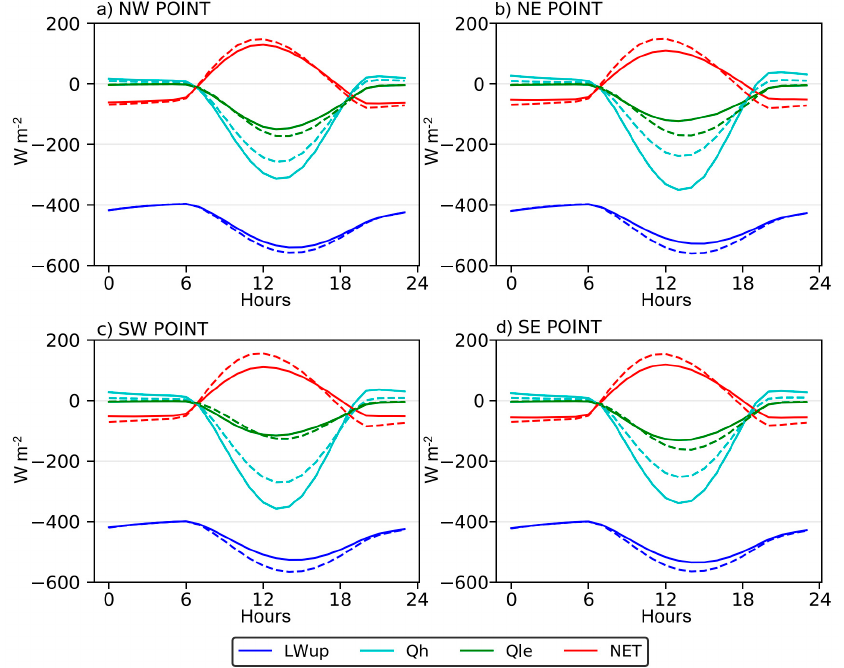
Figure 9. Components of the surface energy balance at the surface in the control (solid lines) and revised (dashed lines) simulations. Longwave upward radiation (LWup, blue), sensible heat flux (Qh, cyan), latent heat flux (Qle, green) and the surface net flux (NET = SWnet + LWnet + Qh + Qle, solid red). The fluxes sign conventions indicate fluxes to the surface as positive and fluxes leaving the surface as negative. The downward and net solar radiation (SWdown, SWnet) and longwave downward radiation (LWdown) are identical in both simulations and are represented in Figure S7. Each panel represents one of the 4 points of the Southern Portugal domain ( a ) North West, ( b ) North East, ( c ) South West ( d ) South East (see Figure